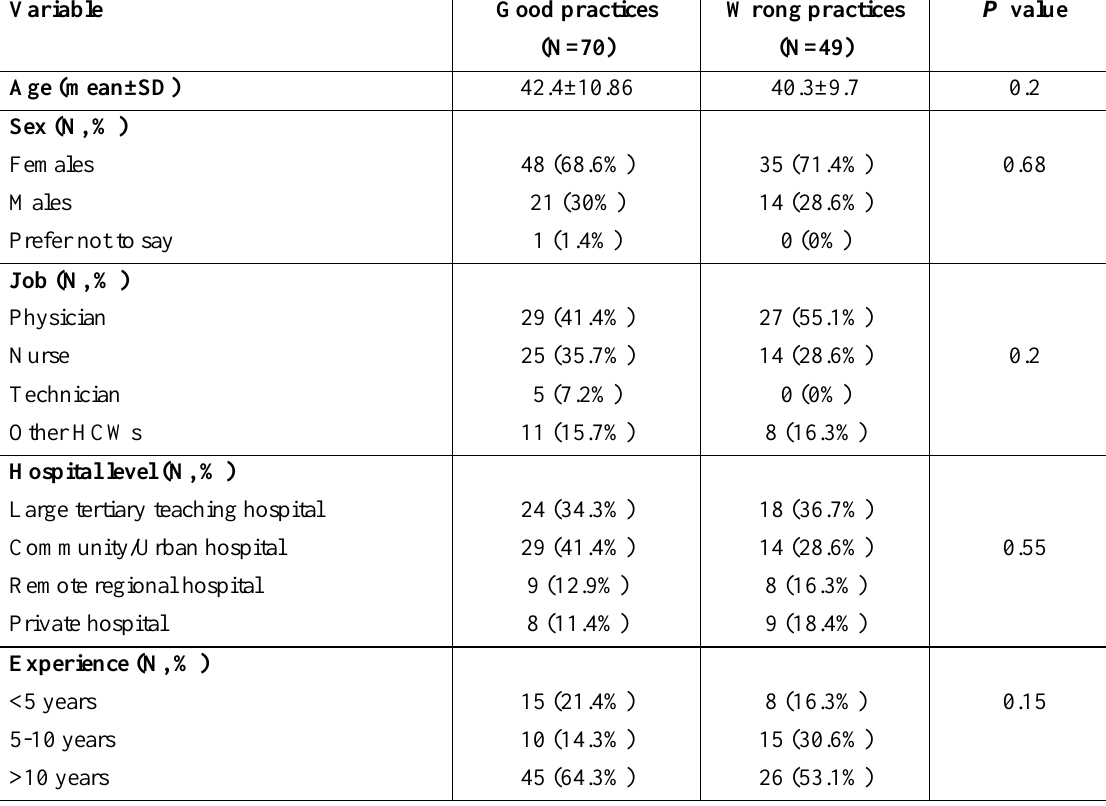
Table 3. Demographic factors related to correct and wrong PPE practices among the studied participants. Variable Good practices